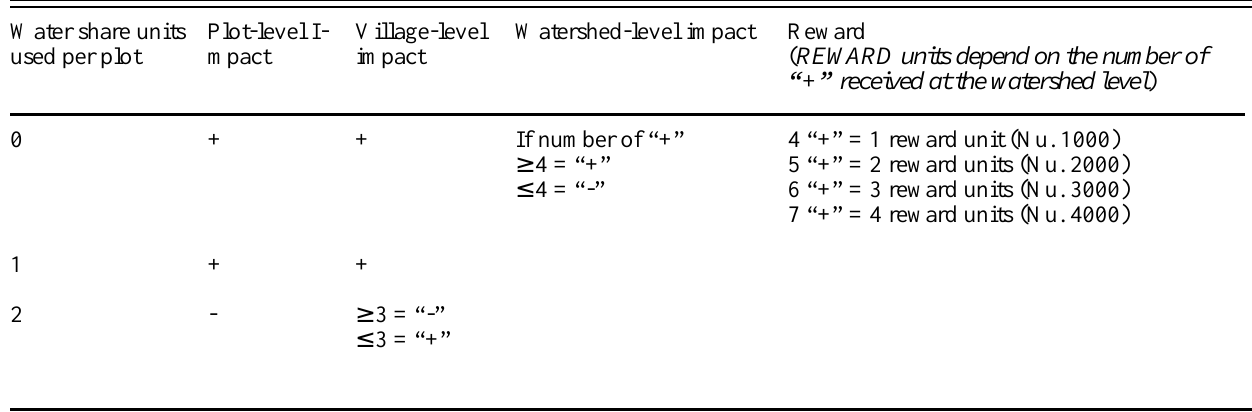
Table 9. Impact of water use and reward for better management Water share units Plot-level I used per plot